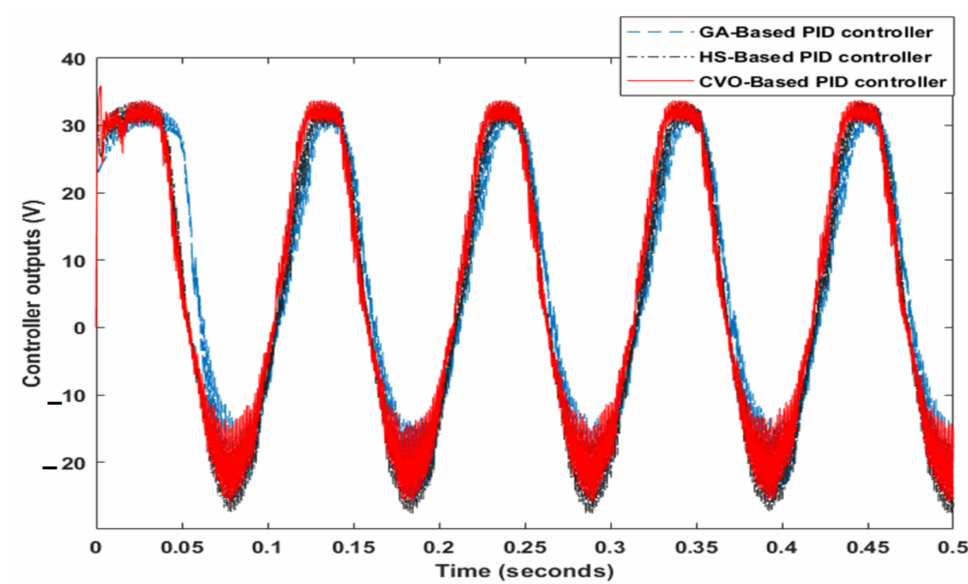
Figure 11. The controller outputs at the sinusoidal load